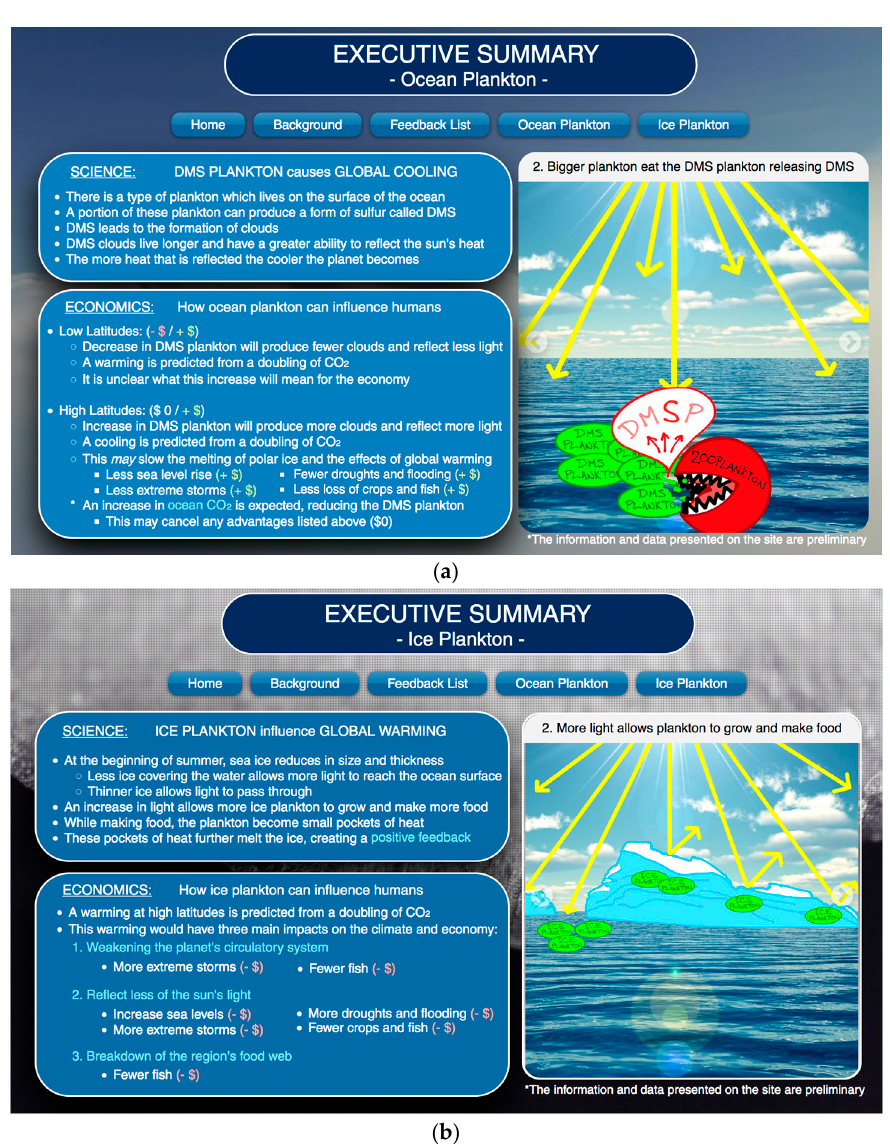
Figure 2. “Executive Summary” pages included on the website for the DMS cloud-albedo ( a ) and ice chlorophyll feedback ( b ).